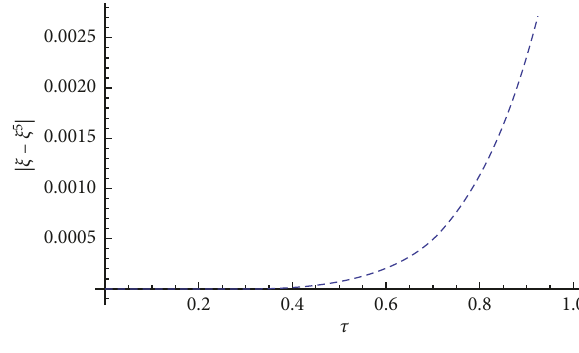
Figure 4: The absolute errors of Example 2. Table 2: The absolute errors for Example 2 at λ